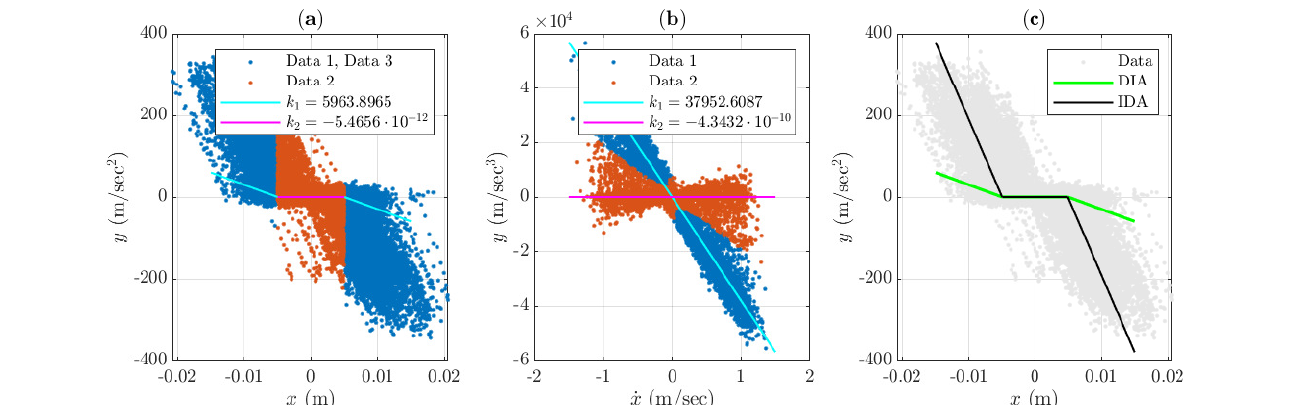
Figure 6. Results of the Lin-Ewin system identification with DIA and IDA with additive Gaussian noise. The legend is similar to Figure 5: ( a ) DIA; ( b ) IDA; both results are shown in ( c ). DIA failed in estimating k 1 and IDA was still fruitful, while k 2 in both cases was estimated